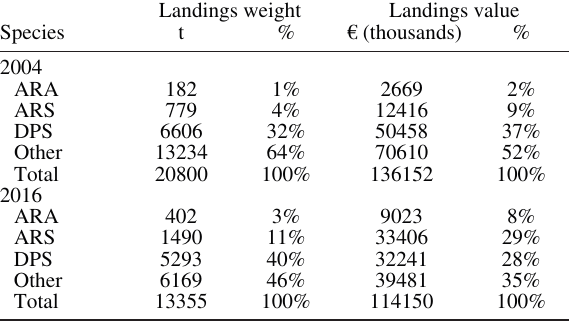
Table 2. – Species composition of the trawl fleet in the Strait of Sicily. ARA, blue and red shrimp ( Aristeus antennatus ); ARS, giant red shrimp ( Aristaemorpha foliacea ); DPS, deepwater rose shrimp ( Parapenaeus longirostris ). Source: MIPAAF data sourced from IREPA (2004 data) and ITAFISHSTAT (2016